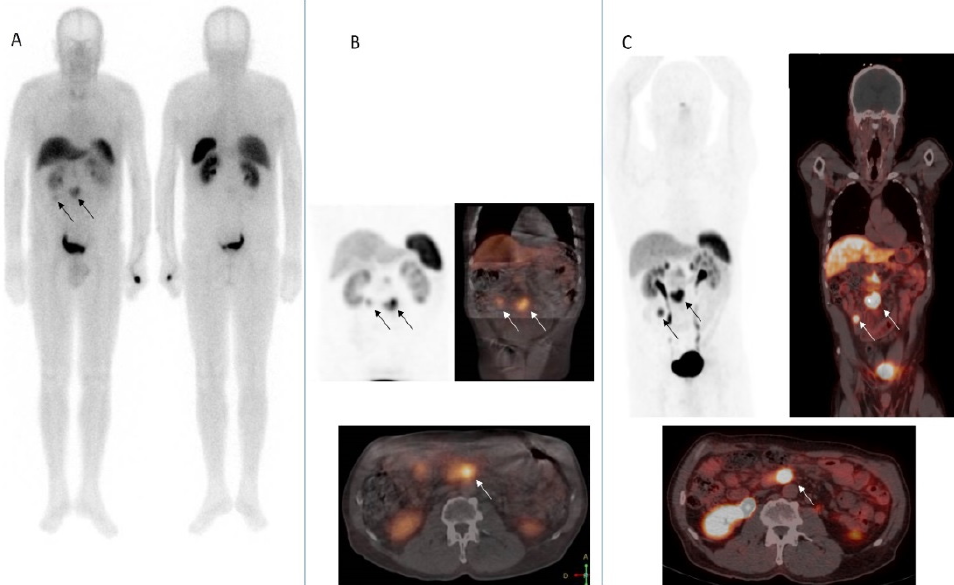
Figure 3. Comparison between somatostatin receptor functional images in a patient with midgut NET. ( A ). [99mTc] EDDA-HYNIC-Thr3-octreotide whole body scan in anterior and posterior projection. ( B ). [99mTc] EDDA-HYNIC-Thr3-octreotide SPECT/CT. Up to the left 3D reconstruction. Up to the right and down, SPECT/CT fusion in coronal and axial slices. ( C ). [68Ga]Ga-DOTA-TOC PET/CT. Up to the left maximum intensity projection. Up to the right and down PET/CT fusion in coronal and axial slices. The arrows point out the primary midgut NET and a mesenteric mass overexpressing somatostatin receptors. Table 1. Overall sensitivity and specificity comparing 111In-DTPA-Pentetreotide SPECT/CT and 68Ga-DOTA-SSA PET/CT.